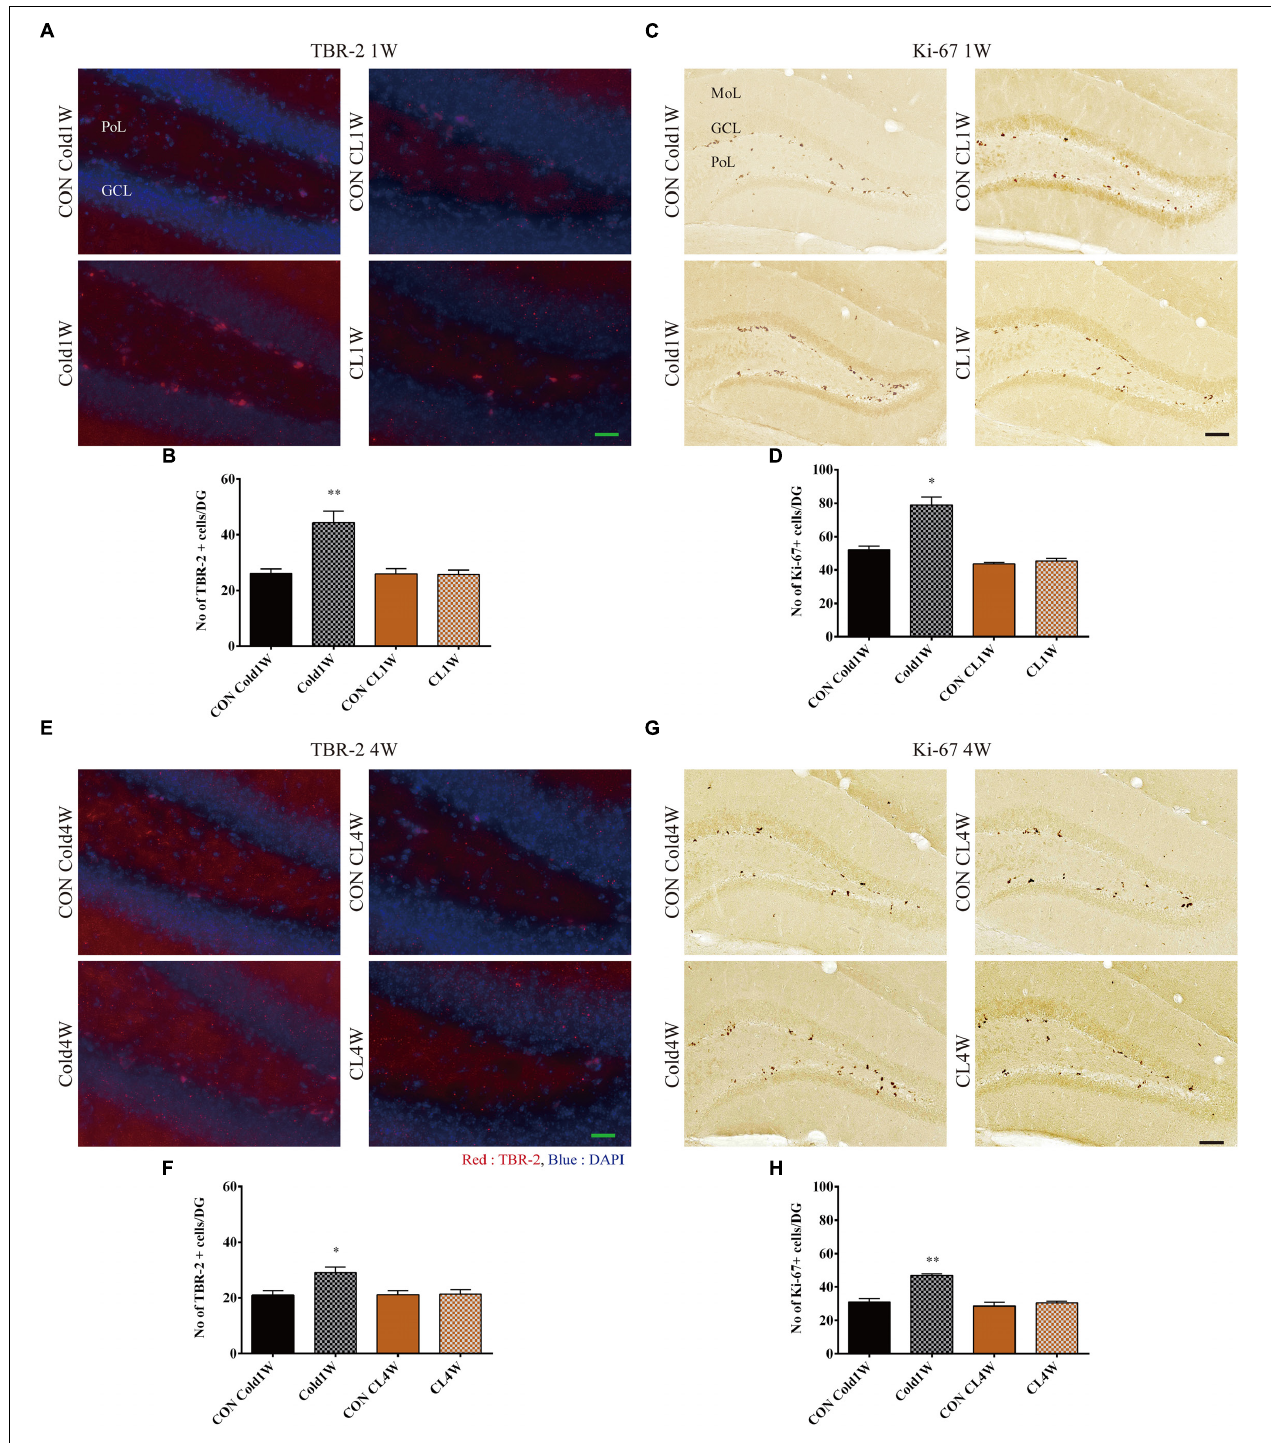
FIGURE 3 | Effects of cold challenge or CL 316,243 treatment for 1 week or 4 weeks on the TBR-2 and Ki-67 positive cells in the dentate gyrus. Note that the TBR-2 and Ki-67 positive cells are abundant in the Cold1W and Cold4W groups when compared with that in the CON Cold1W and CON Cold 4W groups, respectively (A,C,E,G) . However, the CON CL1W, CL1W, CON CL4W, and CL4W groups show similar populations of TBR-2 and Ki-67 positive cells in the dentate gyrus (A,C,E,G) . GCL, granule cell layer; MoL, molecular layer; PoL, polymorphic layer. Quantitative analysis of TBR-2 and Ki-67 positive cells per section in the CON Cold1W, Cold1W, CON Cold4W, Cold4W, CON CL1W, CL1W, CON CL4W, and CL4W groups (B,D,F,H) ( n = 5 per group); ∗ indicates a significant difference when compared with the CON group ( p < 0.05); and ∗∗ indicates a significant difference when compared with the CON group ( p < 0.01). Data are shown as mean + SEM. Black scale bar = 100 µ m and green scale bar = 25 µ